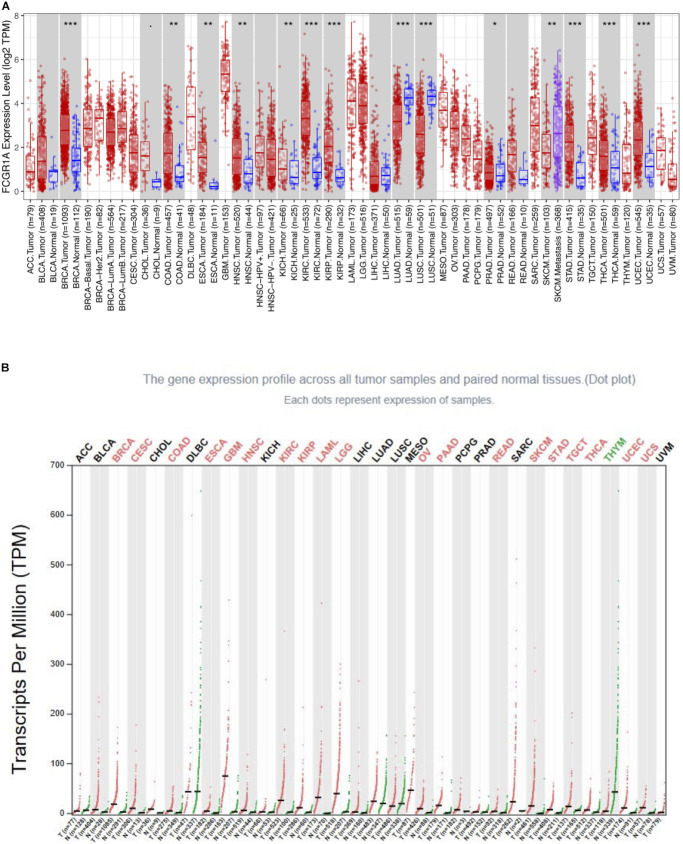
FCGR1A expression in different cancers types. (A) FCGR1A expression levels in different cancer types from TCGA database were performed by TIMER (*P < 0.05, **P < 0.01, ***P < 0.001). (B) Increased or decreased FCGR1A expression of different cancers compared with normal tissues in GEPIA.